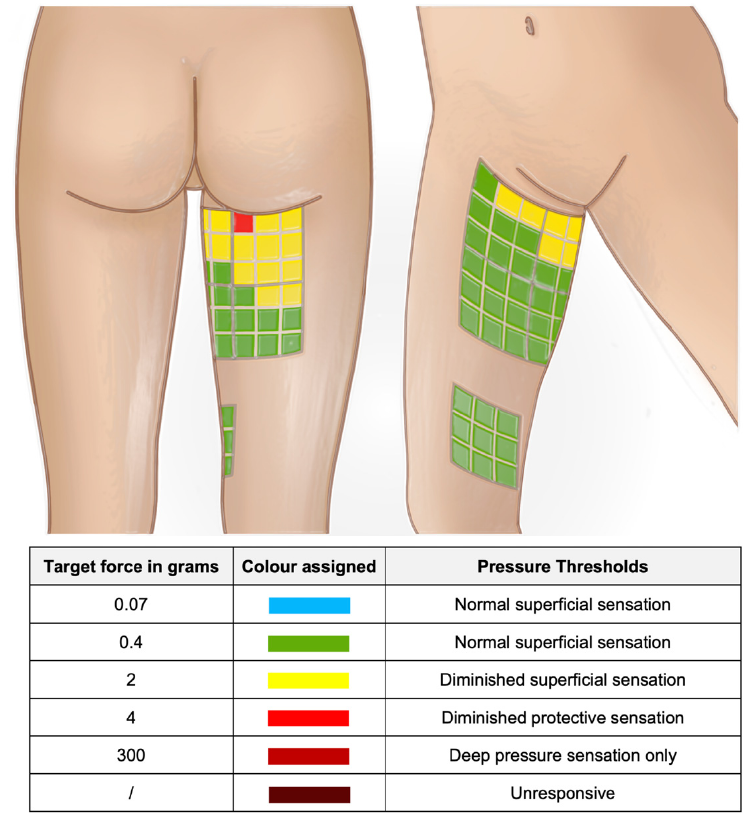
Figure 2. Skin sensation on the donor thigh. For each of the seven quadrants on the donor thigh, the average pressure thresholds have been examined and were categorized with colors, as indicated in the legend. According to the average pressure threshold, each square in the quadrant has been colored.